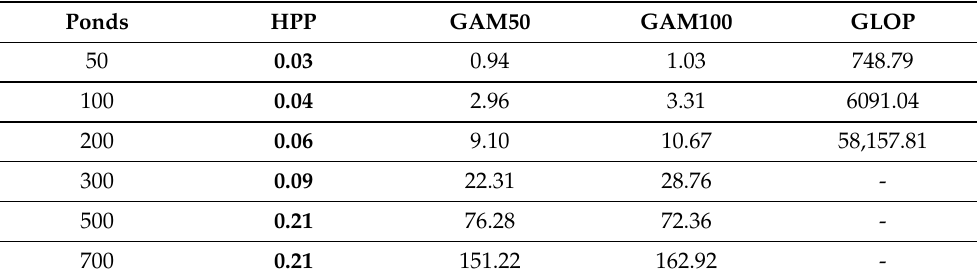
Table 6. Average Run Time in Wind